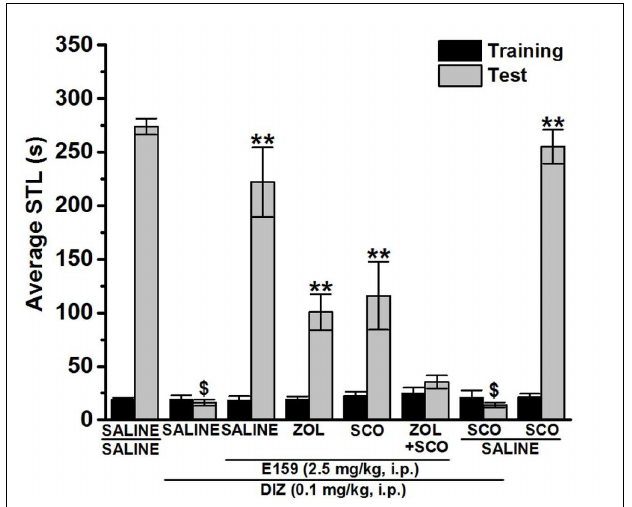
FIGURE 5 | Effects of E159 on DIZ-induced STM cognitive deficits in the object recognition test in rats. Thirty minutes following training session T1, E159 (2.5 mg/kg), RAMH (10 mg/kg), DOZ (1 mg/kg), or DIZ (0.1 mg/kg) was administrated intraperitoneally. The test session T2 was performed 120 min (STM) after the training session T1. Results are calculated as individual percentage of time spent exploring familiar (black columns) and novel (gray columns) objects. Data represent mean ± SEM of 6–8 animals per experimental group. ∗∗∗ P < 0.001 vs. respective familiar object.